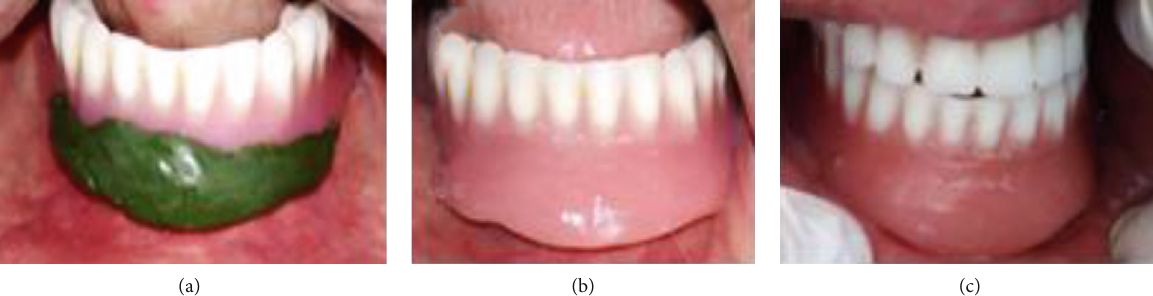
Figure 8: Prostheses adjustments: (a) border molded mandibular prosthesis, (b) chemopolymerized resin molding, and (c) occlusal